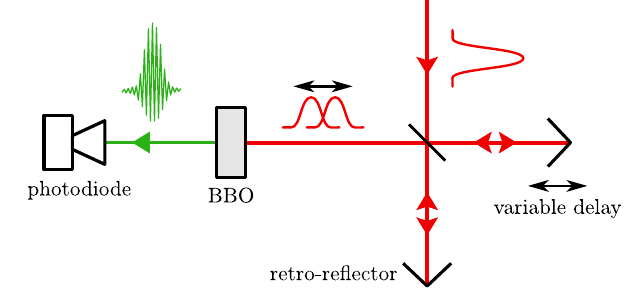
FIG. 9. Schematic of an autocorrelator, consisting of an interferometer with beam splitter, retroreflectors, a variable delay arm, BBO crystal and